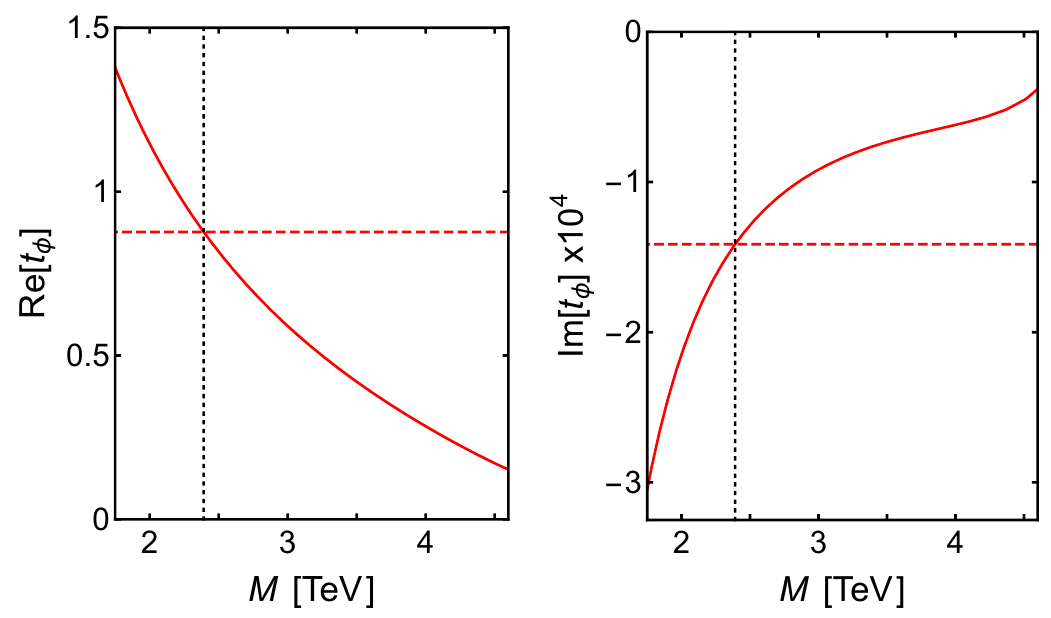
Figure 19 . Real and imaginary parts (left and right panels) of the interaction parameter t (cid:30) = tan (cid:30) for ZREFT at LO as functions of the wino mass M . The complex parameter t (cid:30) ( M ) (solid red curves) is determined from the complex e(cid:11)ective range r 0 in NREFT by the matching condition in eq. (5.36). The vertical dotted lines indicate the unitarity mass M (cid:3) = 2 : 39